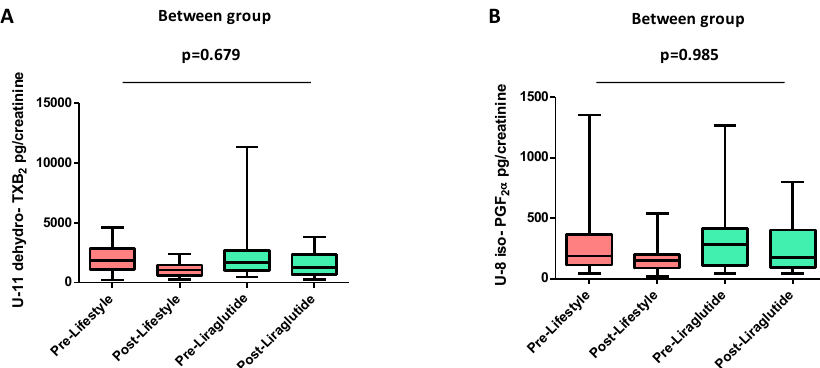
Figure 4. Effects of Liraglutide- or lifestyle-induced weight loss on platelet activation and lipid peroxydation in obese subjects with prediabetes or early type 2 diabetes mellitus. Effect of liraglutide- or lifestyle counseling–induced weight loss on in vivo platelet activation, as assessed by U-11-dehydro-TXB 2 (panel A ), and in vivo lipid peroxidation, as assessed by U-8-iso PGF 2 α (panel B ), in obese patients with prediabetes or diabetes diagnosed within one